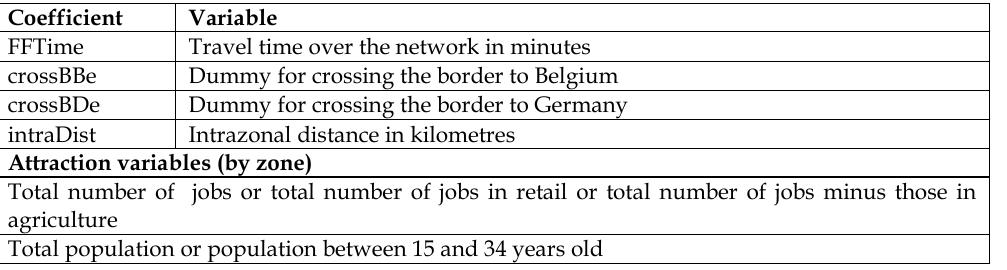
Table 3. Variables in the simplified destination choice